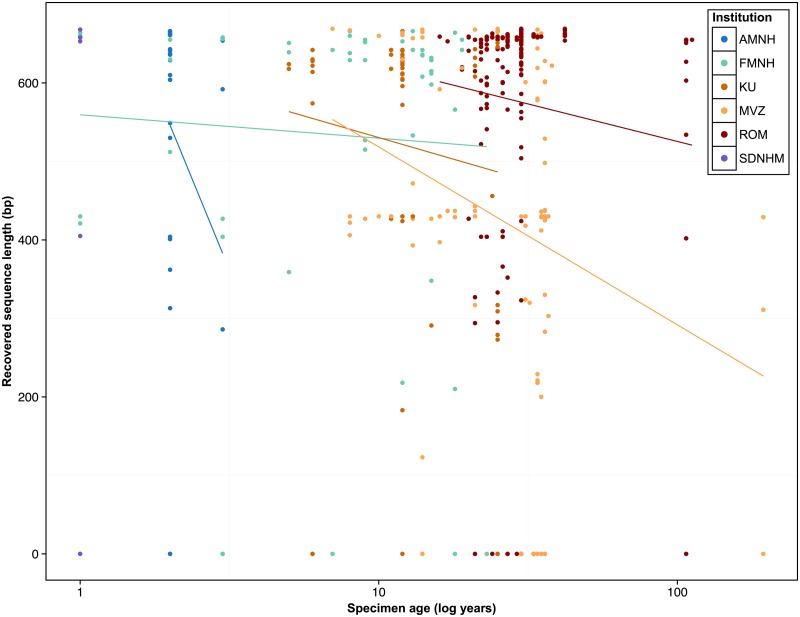
Relationship between sample age and recovered sequence length from six collections in reptiles and amphibians.AMNH: American Museum of Natural History; FMNH: Field Museum of Natural History; KU: University of Kansas Biodiversity Institute; MVZ: Museum of Vertebrate Zoology; ROM: Royal Ontario Museum; SDNHM: San Diego Natural History Museum; UAHC: University of Alabama, Alabama Museum of Natural History Herpetological Collection.